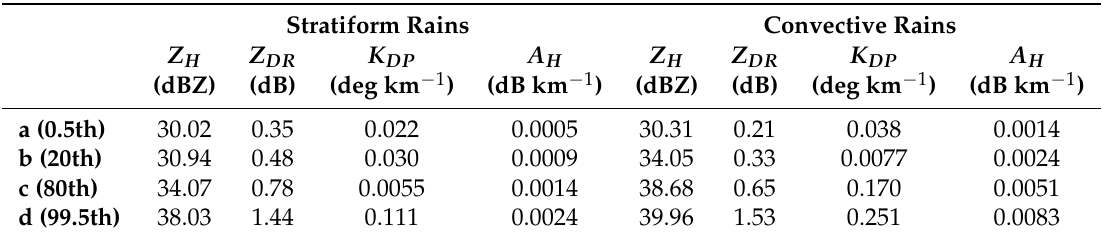
Table A2. Same as Table A1, but for intercept of Z H between 30 and 40 dBZ as presented in Figure 13. Stratiform